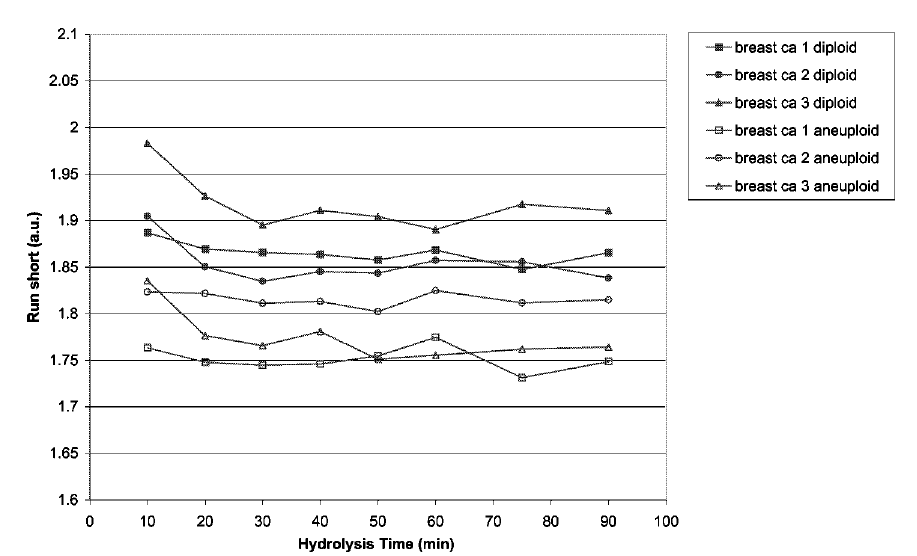
Fig. 5. Hydrolysis profiles based on “short run emphasis” in diploid and aneuploid cell populations of breast